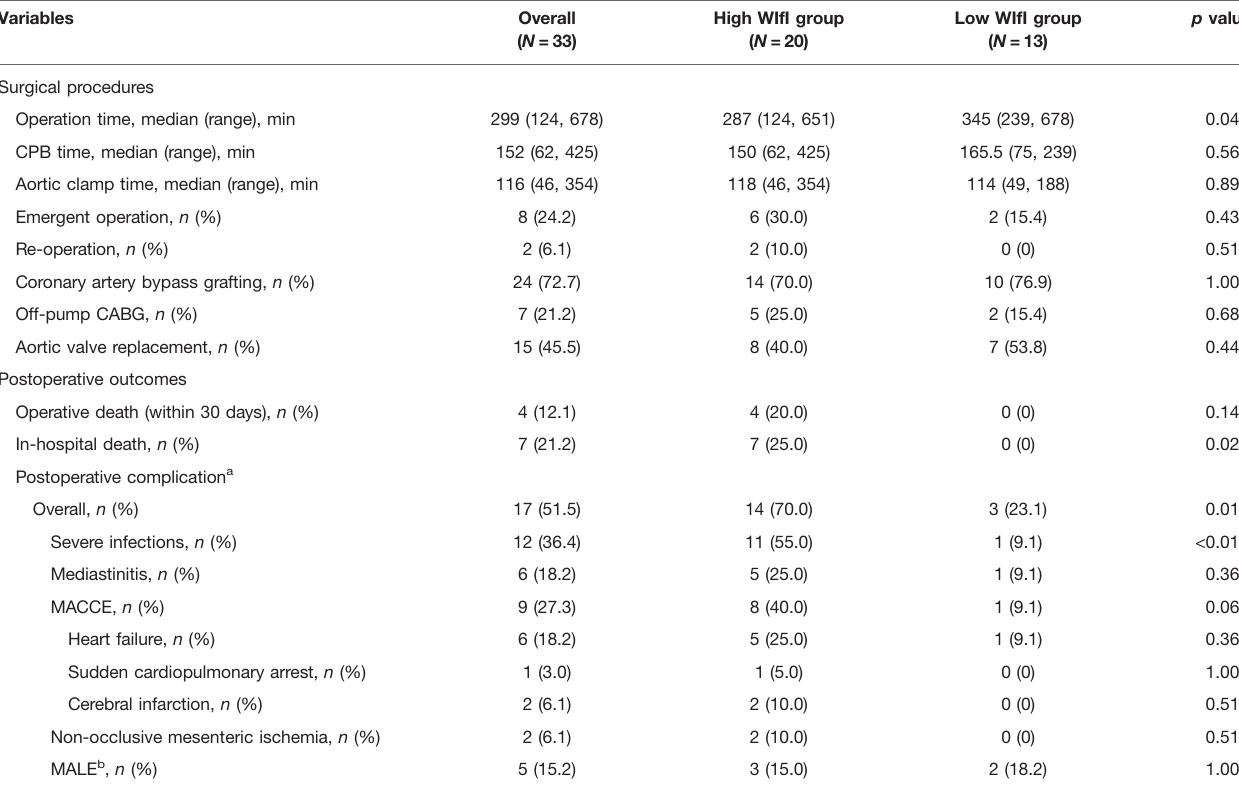
TABLE 2 | Comparison on procedures of cardiac surgery and outcomes between high WIfI group and low WIfI group.